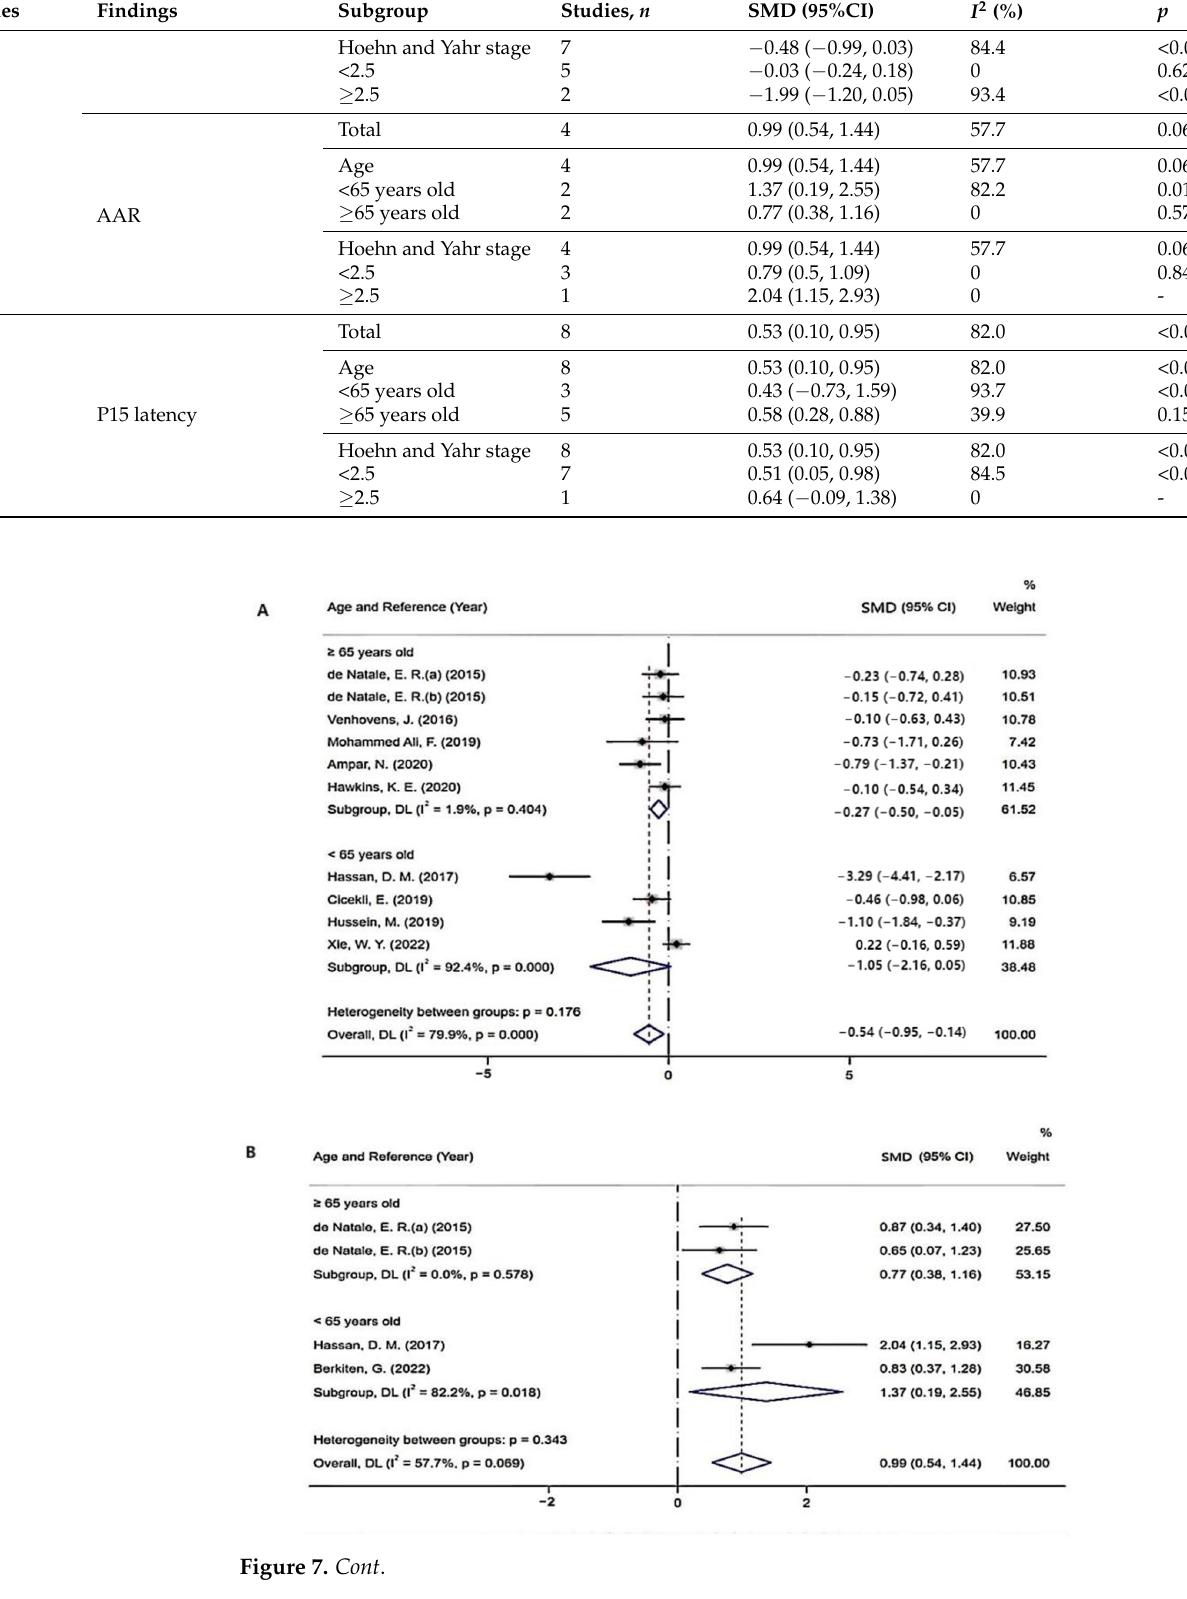
Figure 7. ( A ) Sub-group analysis of peak-to-peak amplitude based on age [8,11,13,15– 17,23,24,26,27]; ( B ) sub-group analysis of P15 latency based on age [7,8,11,23]; ( C ) sub-group analy- sis of peak-to-peak amplitude based on Hoehn and Yahr stage [8,11,13,15,23,26,27]. 4. Discussion